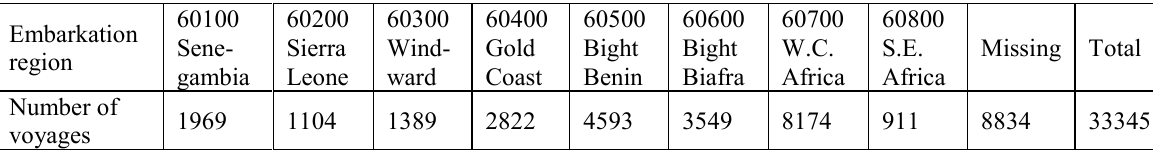
Table 4. WHCDB-2017 voyages by embarkation region, 1650s to